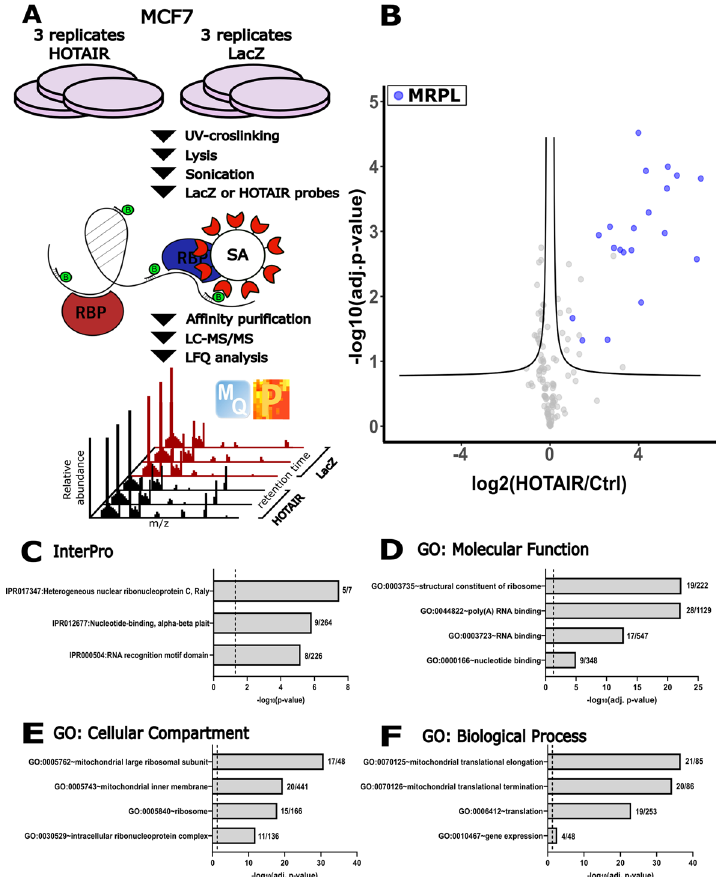
Figure 1. Identification of HOTAIR-interacting proteins by ChIRP-MS. ( A ) Schematic overview of ChIRP-MS. ( B ) Volcano plot showing the potential protein interactors of HOTAIR by ChIRP-MS (FDR 0.05; s0 0.1). MRPLs are highlighted in blue. InterPro domains overrepresented in the data set ( C ). Gene Ontology analysis showing Molecular Function ( D ), Cellular Component ( E ), and Biological Process ( F ). GO was performed with David 6.8., the four most significant terms are shown. The vertical dashed line represents the 0.05 cutoff used for the adjusted p-value. Number of significant proteins identified and the size of each annotation is shown next to each histogram. SA streptavidin, RBP RNA-binding protein, LFQ label free